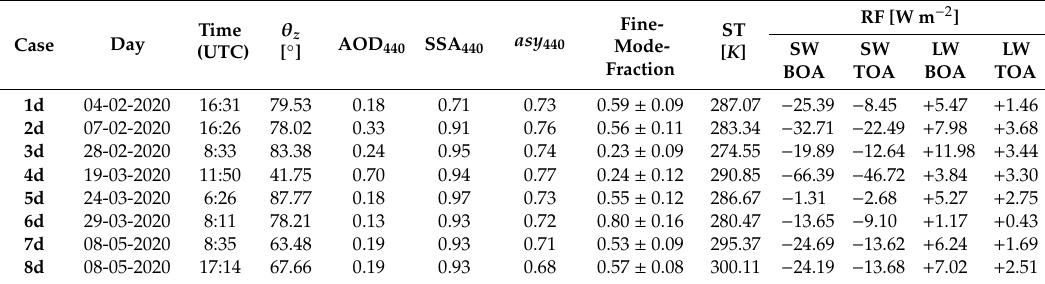
Table 3. Mineral dust radiative forcing (RF, last four columns), at the surface (BOA), and the top of the atmosphere (TOA) for the LW and SW, estimated for the 8 African dust events. Time refers to the ceilometer start time (all ceilometer measurements are of 1 h duration). AOD, SSA (single scattering albedo), and asy (asymmetry factor) are measured by the AERONET sun photometer at 440 nm. θ z stands for the solar zenith angle in degrees. Surface albedo, taken from COPERNICUS Global Land Services, is 0.013 for every case. ST is the surface temperature taken from COPERNICUS Global Land Services. Fine-mode-fraction is shown together with its standard deviation, provided by AERONET. The letter “d” in the case number denotes that these 9 cases are a ff ected by mineral dust.